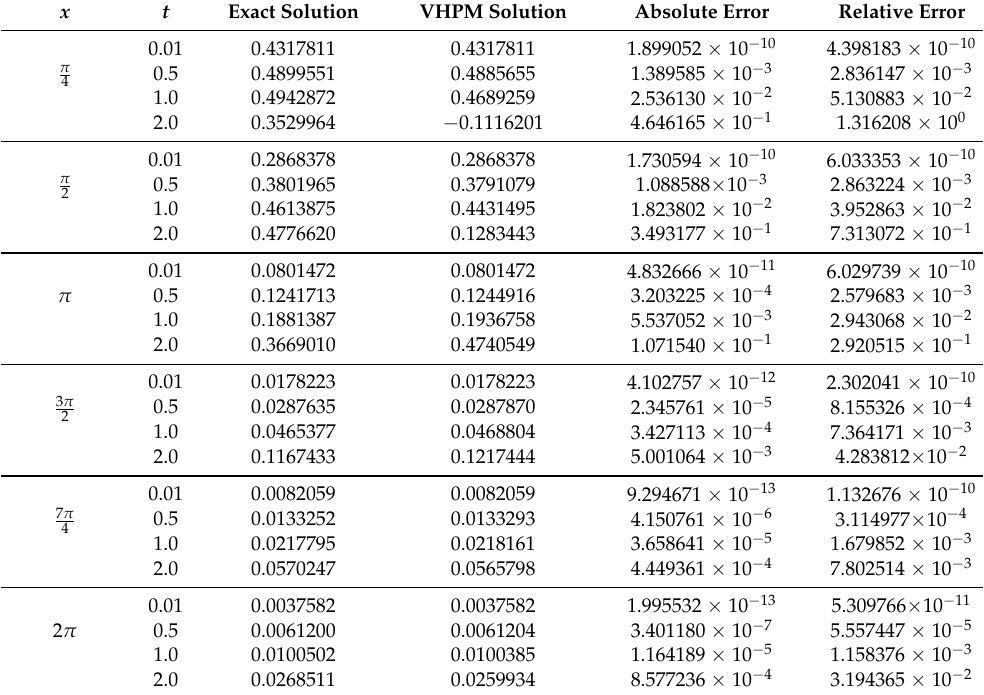
Table 5. Absolute and relative errors (VHPM with n = 4) at some values of x ∈ [ 0,2 π ] and t ∈ [ 0,2.0 ]